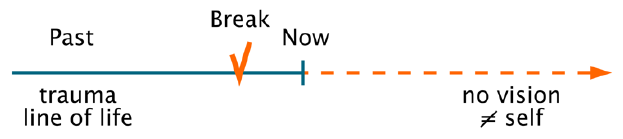
Figure 2. Traumatic experiences breaks the line of life and damage the self-concept.